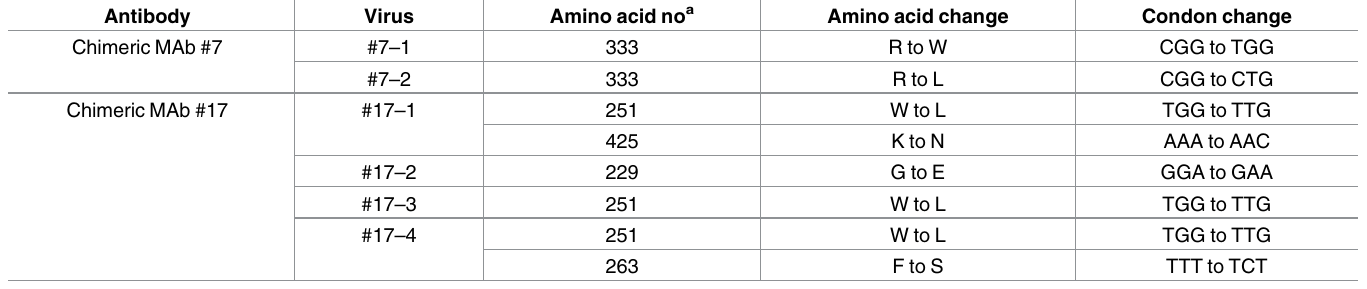
Table 3. Characterization of chimeric MAbs#7 and #17 escape viruses a